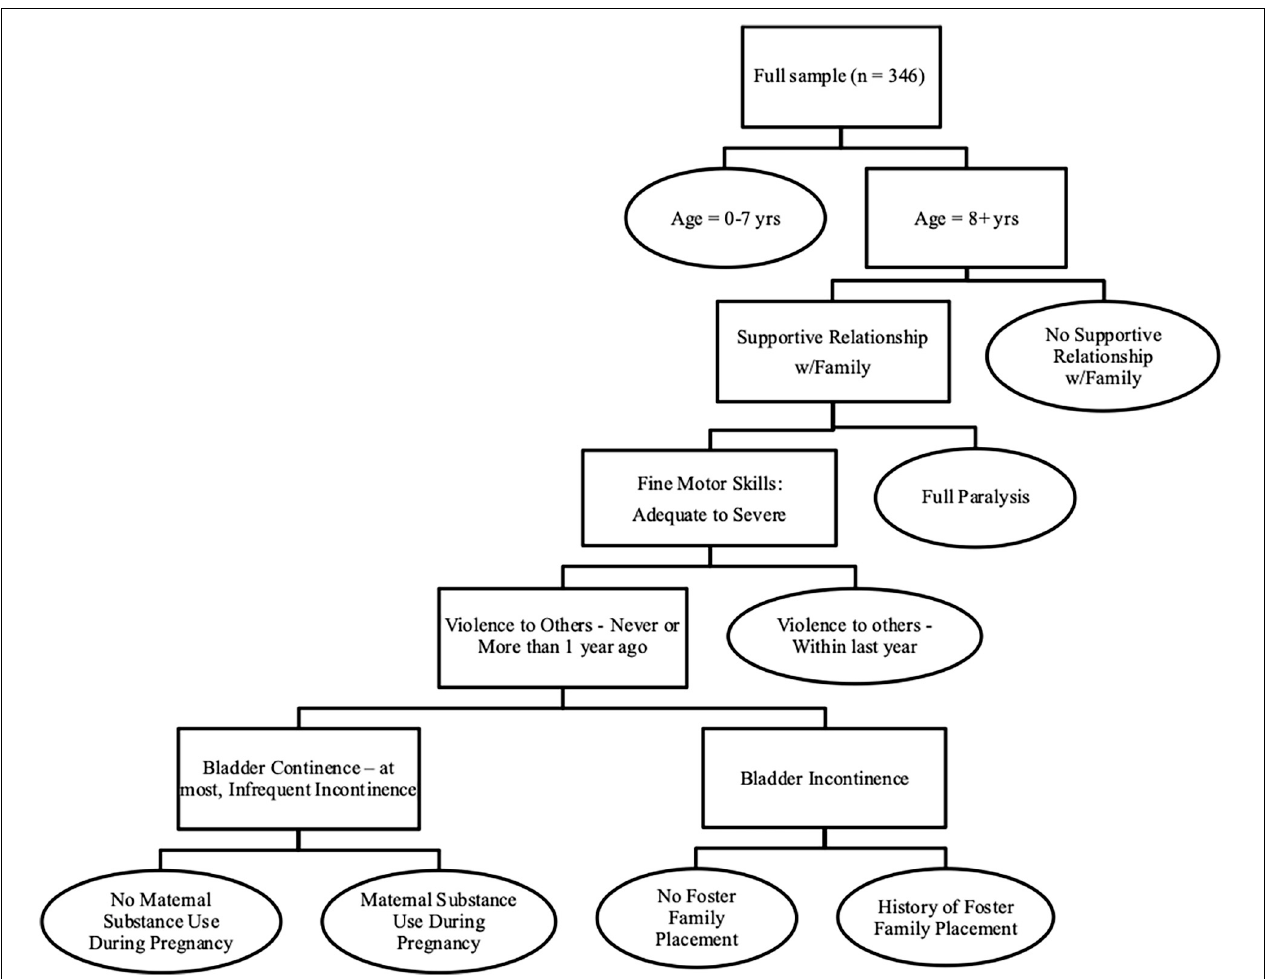
FIGURE 6 | The interRAI Child and Youth Resource Index (ChYRI). Ovals represent terminal ChYRI